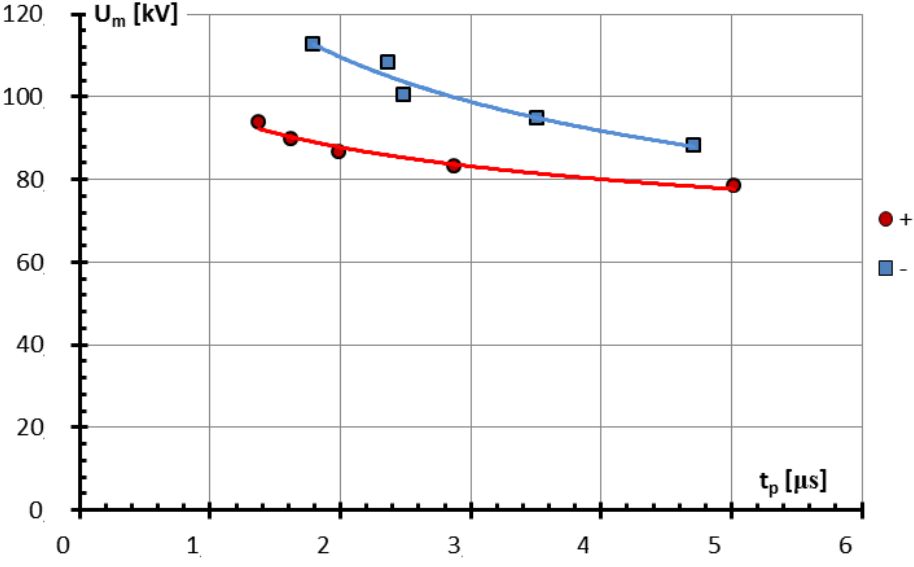
Figure 11. Characteristics of flashover voltage for MCA in terms of positive + and negative −